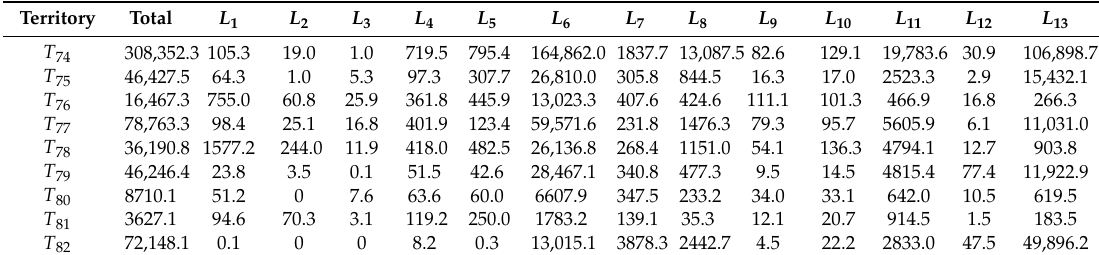
Table A8. Land acreage data of the Far Eastern Federal District in thousand hectares. Mean values for